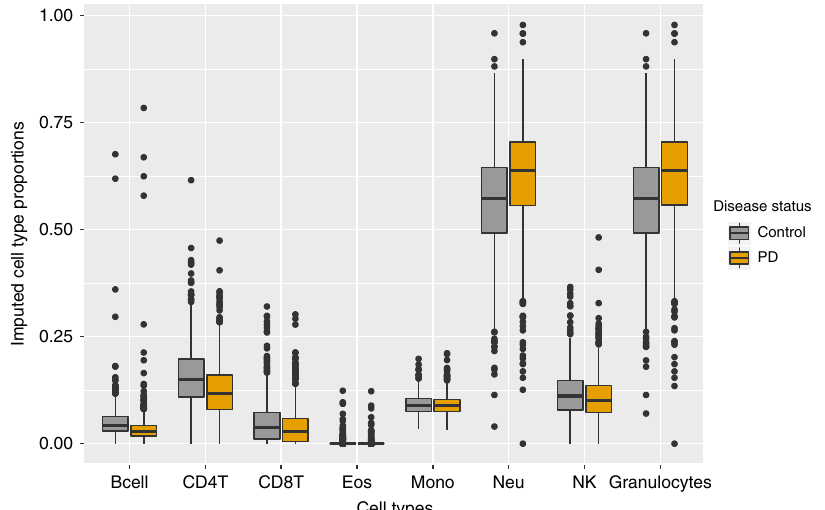
Fig. 1 Distribution of predicted blood cell type proportions (CTPs) in PD and controls. Boxplots of predicted blood CTPs in 1638 unrelated European individuals from the SGPD data set, strati fi ed by PD status (851 PD cases, 787 controls). B cells, p = 2.16 × 10 − 10 ; CD4T cells, p = 2.97 × 10 − 15 ; CD8T cells, p = 5.29 × 10 − 03 ; eosinophils (eos) cells, p = 1.43 × 10 − 01 ; monocytes (mono) cells, p = 2.22 × 10 − 02 ; neutrophils (neu) cells, p < 2 × 10 − 16 ; natural killer (NK) cells, p = 7.53 × 10 − 05 ; granulocytes, p < 2 × 10 − 16 . P values from logistic regression of PD status on predicted age, sex, and individual cell types. Granulocytes are calculated as the sum of eosinophil and neutrophil proportions. Boxplot center lines show the median, box limits denote upper and lower quartiles, whiskers represent 1.5 × interquartile range and individual points show